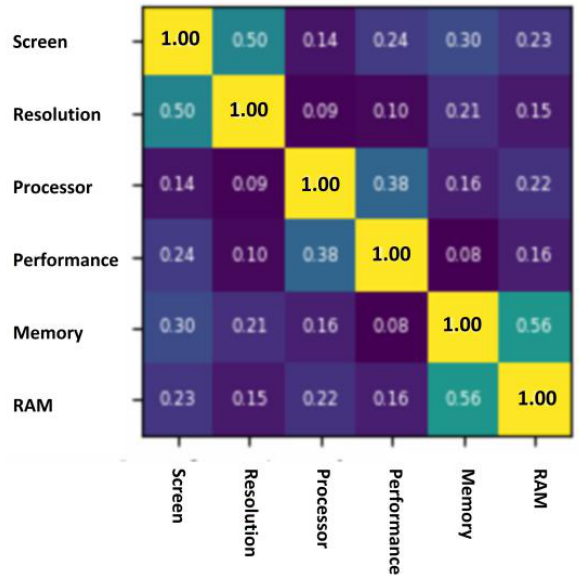
Figure 6. An example of lexical similarity.